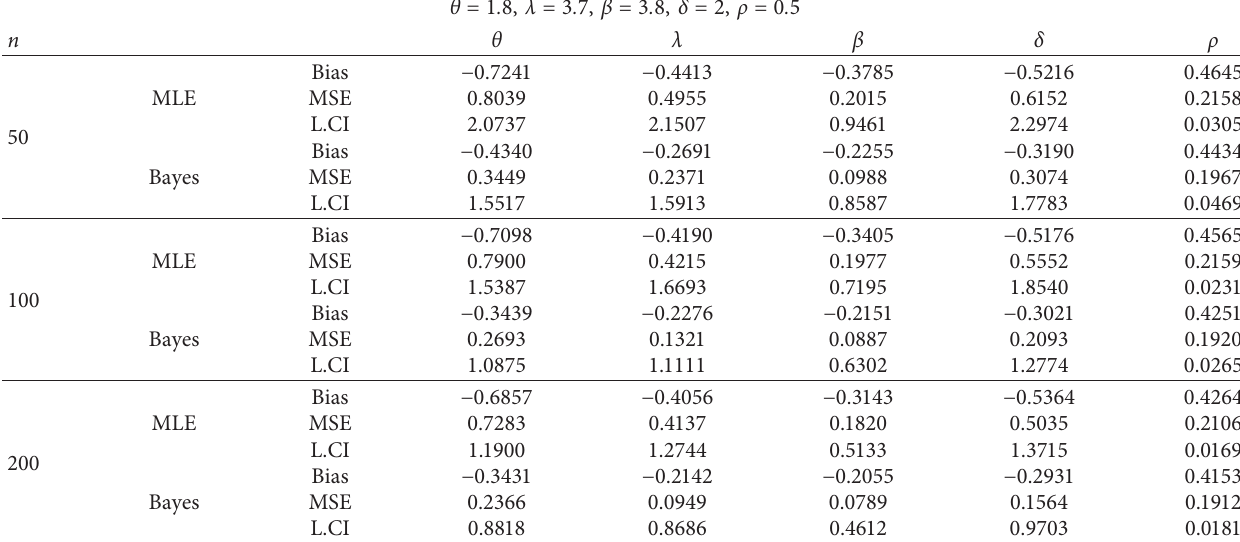
Table 1: MLE and Bayesian estimation with different sample sizes in the independent case.